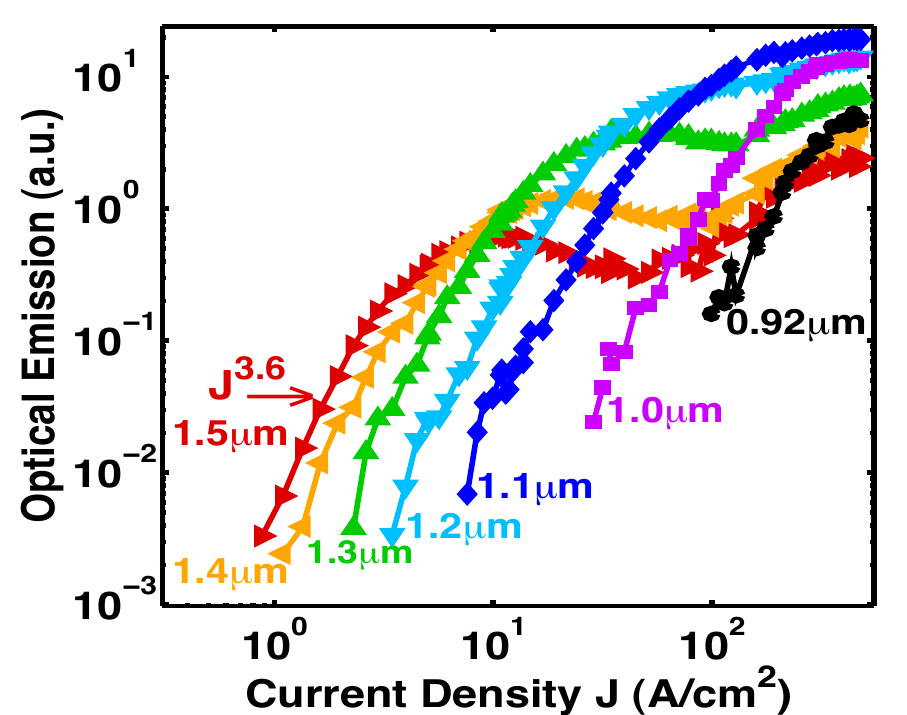
Figure 11 . Room-temperature stimulated-emission measured from the edge of Sample F